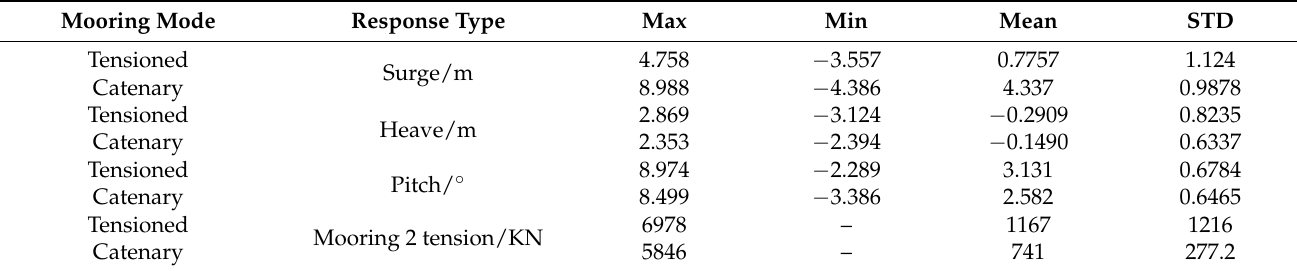
Table 5. Motion response and tension statistics of floating wind